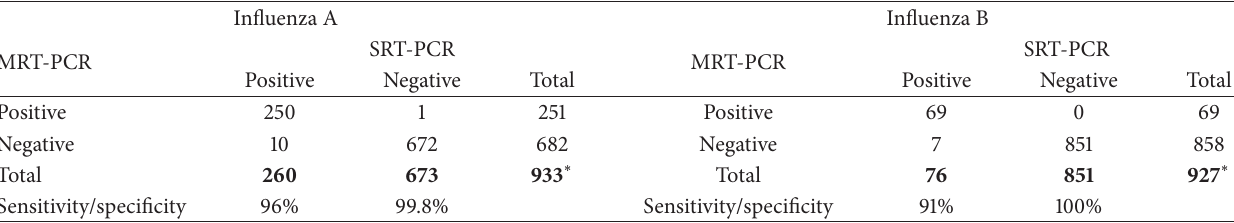
Table 1: Comparison of singleplex reverse transcriptase polymerase chain reaction (SRT-PCT) with multiplex reverse